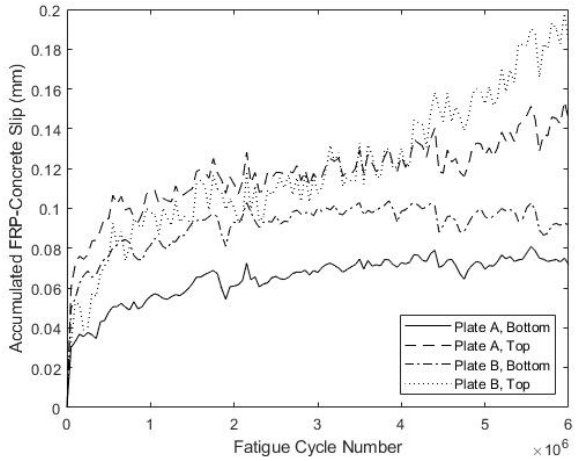
Figure 19. Fatigue-Induced Slip at FRP-Concrete Interface for S6.